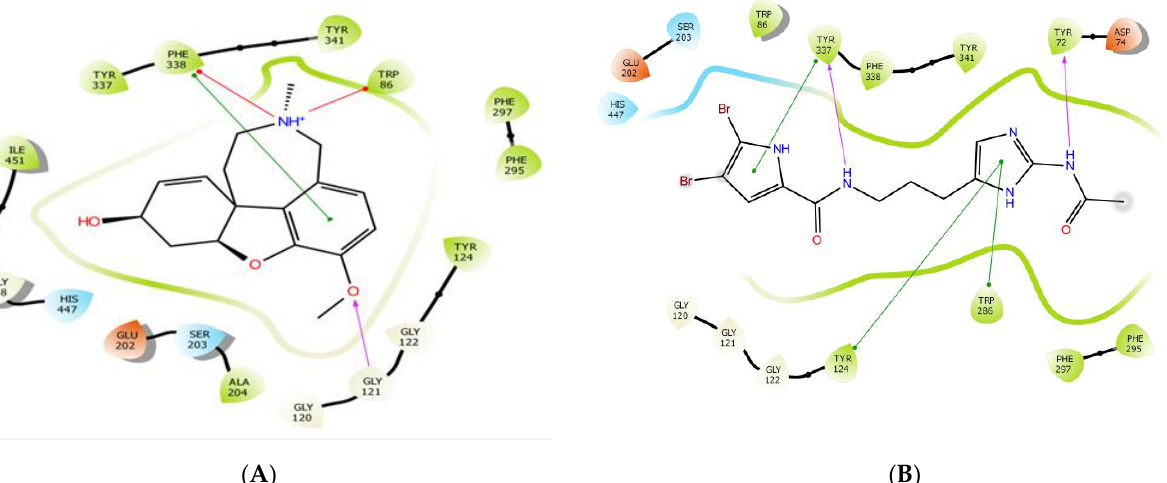
Figure 3. Prediction binding mode of galantamine ( A ) and N-acetyl-17-oroidine ( B ) into the whole AChE active pocket. Red lines indicate π–cation interactions, green lines π–π stacking, and purple arrows show the direction of hydrogen bonding from the donor to the acceptor. The diagrams were made with the Ligand Interaction Diagram script from the Schrödinger Suite. Table 3. Molecular docking scores and interactions of N-acetyl-17-oroidine with AChE- and BChE- active